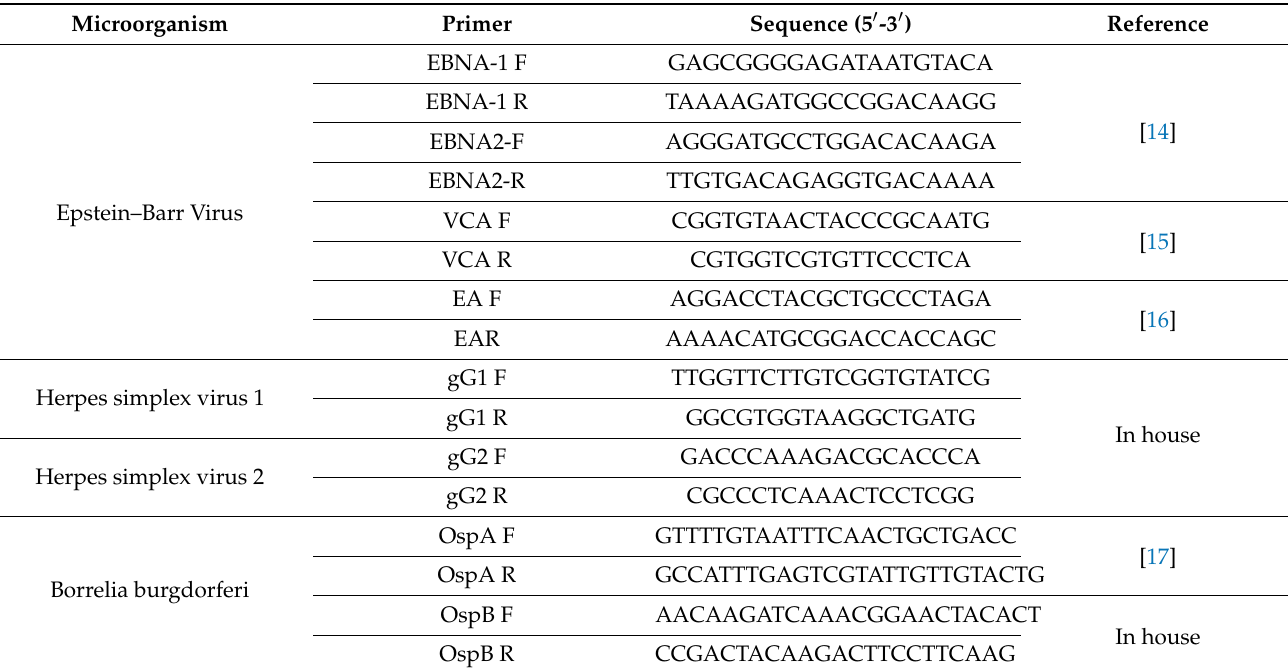
Table 1. Primer sequences for the different microorganisms. Primer Sequence (5 (cid:48) -3 (cid:48)